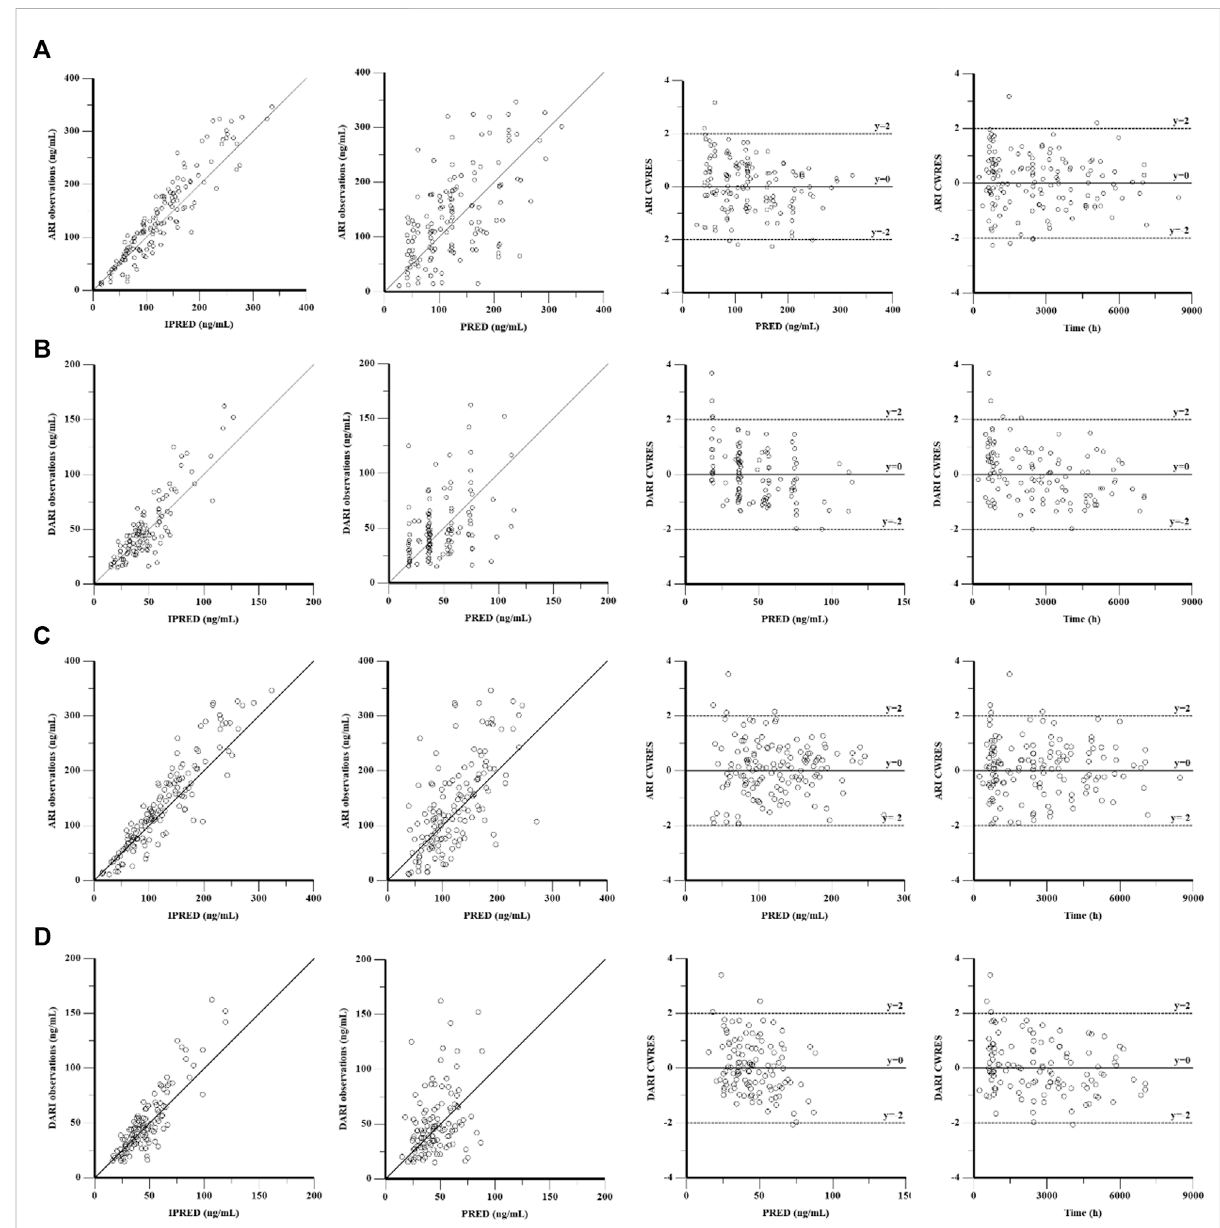
FIGURE 1 Goodness-of- fi t plot of the base model and fi nal population pharmacokinetics model for ARI (A,C) and DARI (B,D) . From left to right, the plots are observations against individual predictions (IPRED), observations against population predictions (PRED), conditional weighted residuals (CWRES) against PRED, and CWRES against time,